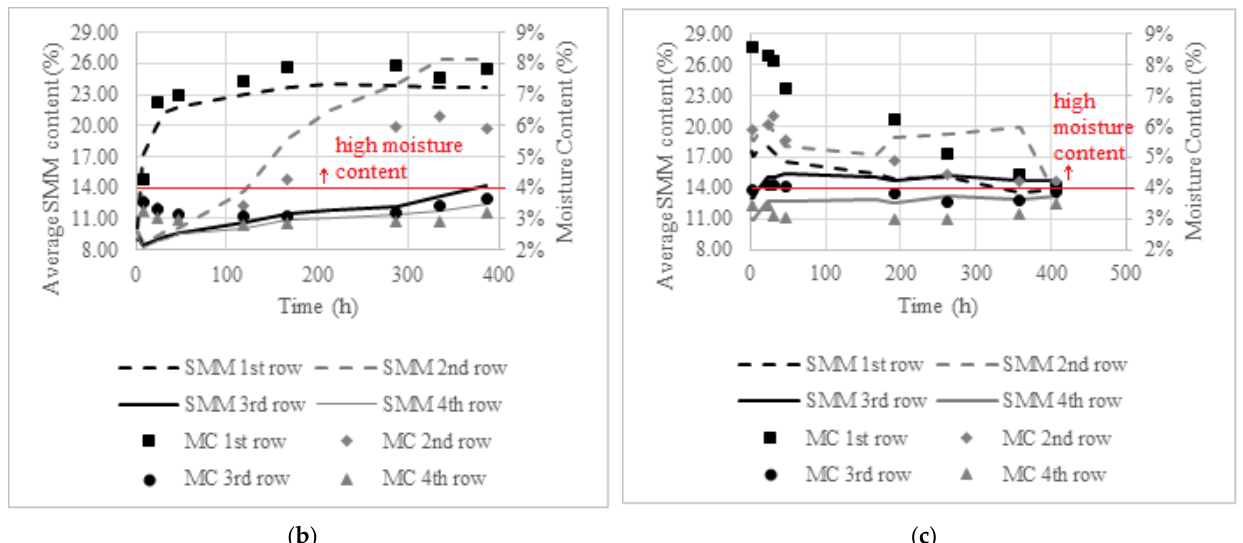
Figure 11. Average SMM results and moisture content (MC): ( a ) humidification—hot chamber; ( b ) humidification—cold chamber; ( c ) drying—cold chamber.